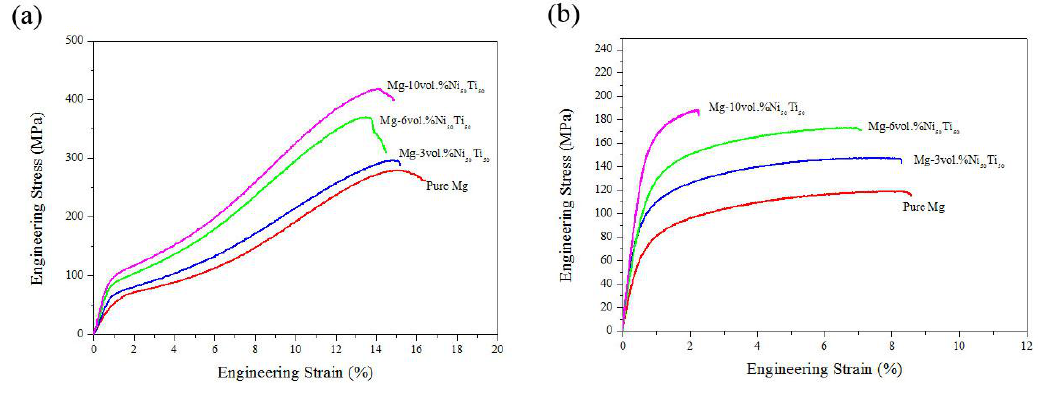
Figure 16. Engineering stress-strain curves of the developed Mg-composites under ( a ) compressive loading ( b ) tensile loading (reprinted from Sankaranarayanan et al . 2015 [17], with permission from ©